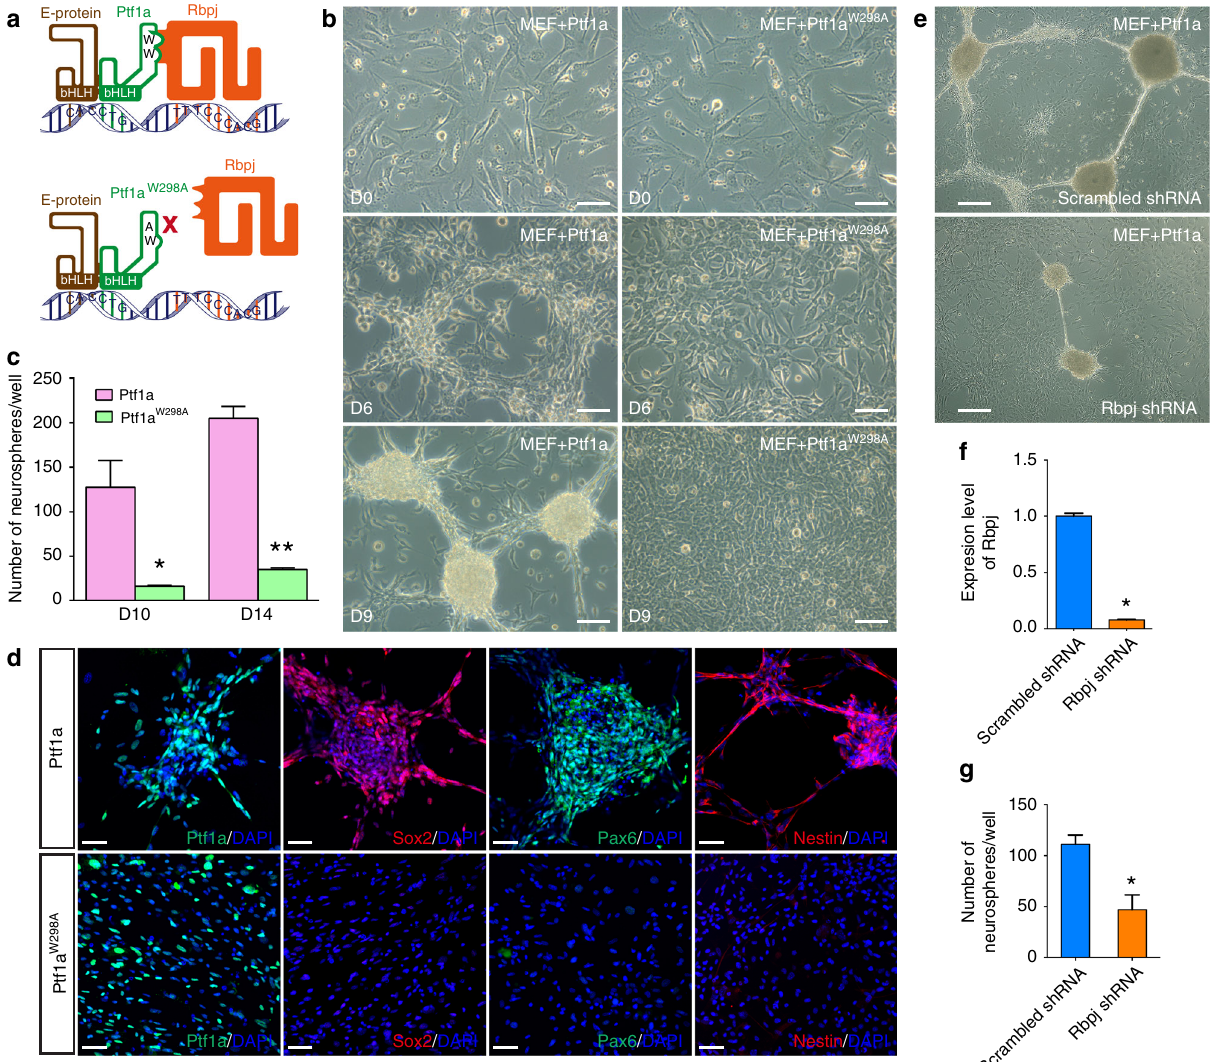
Fig. 7 Ptf1a reprogramming activity depends on Notch-independent interaction with Rbpj. a Schematic depicting the trimeric DNA-binding complex formed among Ptf1a, Rbpj, and an E-protein, as well as the Ptf1a W298A C-terminal mutant that lacks the ability to interact with Rbpj. b Unlike Ptf1a lentivirus- infected MEFs, MEFs transduced with Ptf1a W298A lentiviruses failed to undergo morphological changes by day 6 or form neurospheres by day 9. c Quanti fi cation of neurospheres induced by Ptf1a and Ptf1a W298A . MEFs (4 × 10 4 ) were seeded into each well of 12-well plates, infected with Ptf1a or Ptf1a W298A viruses, and neurospheres in each well were then counted at day 10 and 14 following virus infection. There was a dramatic decrease of neurospheres in Ptf1a W298A -induced samples at day 10 and 14. Data are presented as mean ± SD ( n = 3). Asterisks indicate signi fi cance in unpaired two- tailed Student ’ s t -test: * P < 0.005, ** P < 0.0001. d MEFs infected with Ptf1a lentiviruses generated neurospheres at day 8 that were immunoreactive for Sox2, Pax6, and Nestin, whereas MEFs infected with Ptf1a W298A viruses were negative for these NSC markers. Cells were counterstained with nuclear DAPI. e Neurosphere formation by Ptf1a in MEFs infected with lentiviruses expressing Rbpj shRNA or scrambled Rbpj shRNA. f Relative expression levels of Rbpj in MEFs infected with lentiviruses expressing Rbpj shRNA or scrambled Rbpj shRNA as determined by qRT-PCR assay. Data are presented as mean ± SD ( n = 6). Asterisk indicates signi fi cance in unpaired two-tailed Student ’ s t -test: * P < 0.0001. g Quanti fi cation of neurospheres induced by Ptf1a in the presence of Rbpj shRNA or scrambled Rbpj shRNA. MEFs (4 × 10 4 ) were seeded into each well of 12-well plates, infected with Ptf1a lentiviruses and viruses expressing Rbpj shRNA or scrambled Rbpj shRNA. Neurospheres in each well were counted at day 10 following virus infection. Data are presented as mean ± SD ( n = 6). Asterisk indicates signi fi cance in unpaired two-tailed Student ’ s t -test: * P < 0.0005. Scale bars, 160 μ m ( e ), 80 μ m ( b ), and 40 μ m ( d